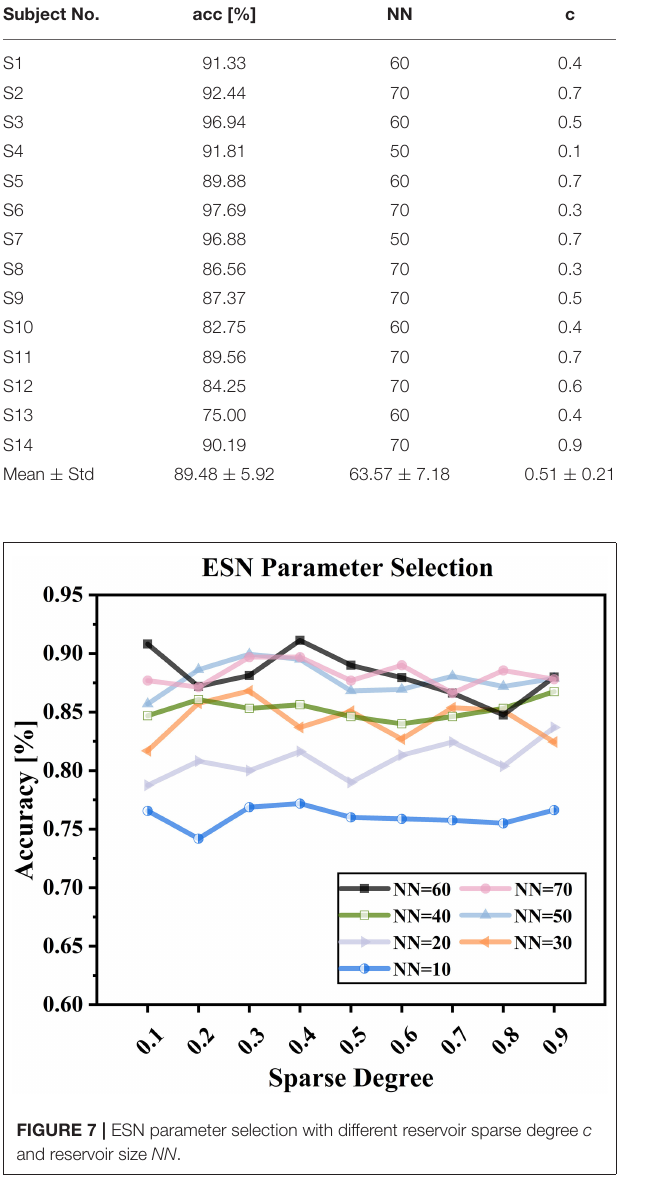
Table 4 shows the computational time comparison results of different decoding models. The total computational time included the sum of signal processing, feature extraction, dimensionality reduction, and classification of a single sample. For the proposed model, averaged NN and c (64 and 0.5) calculated from Table 2 was used for calculating